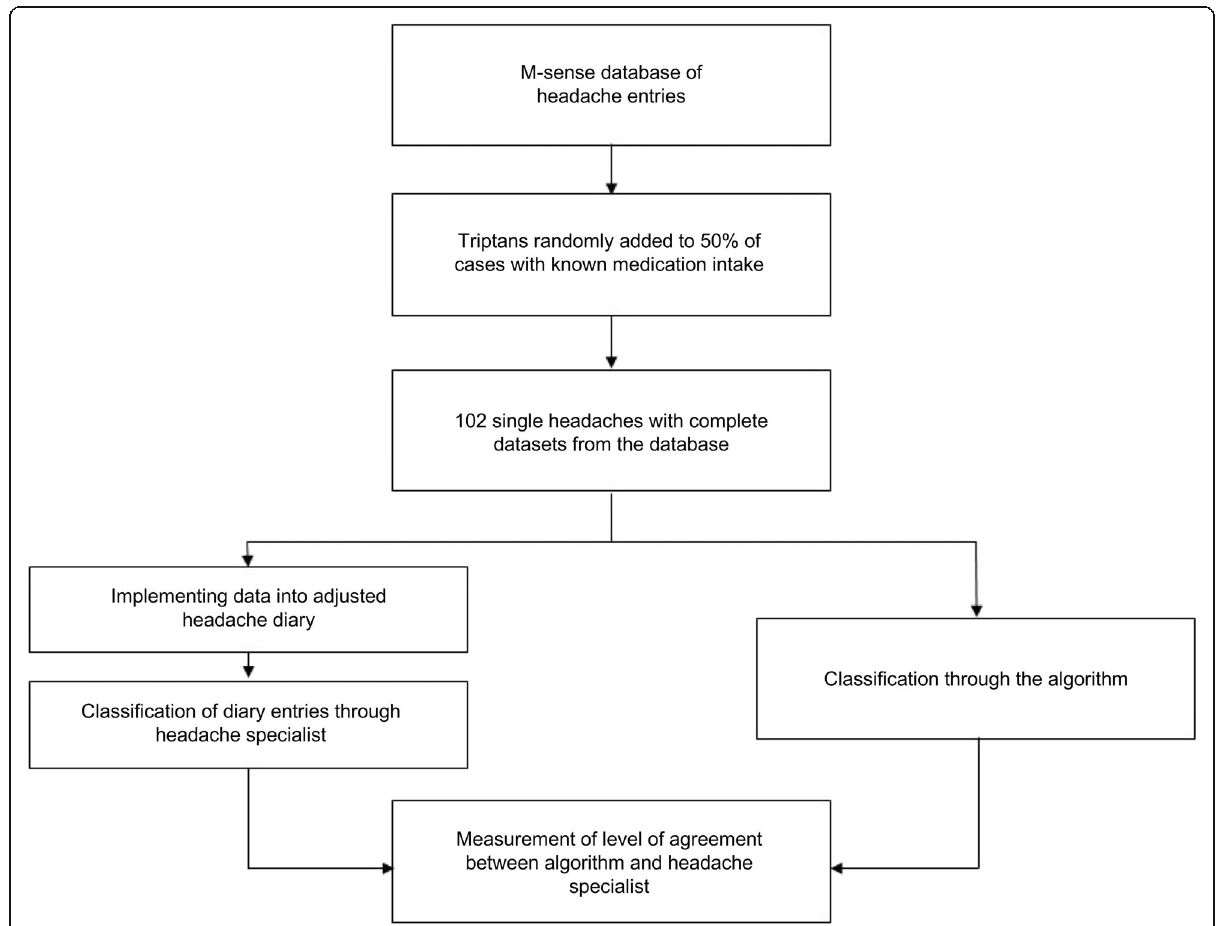
Fig. 4 Flowchart for data collection and validation